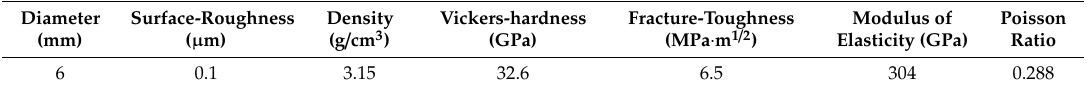
Table 2. Size and mechanical properties of Si 3 N 4 ceramic